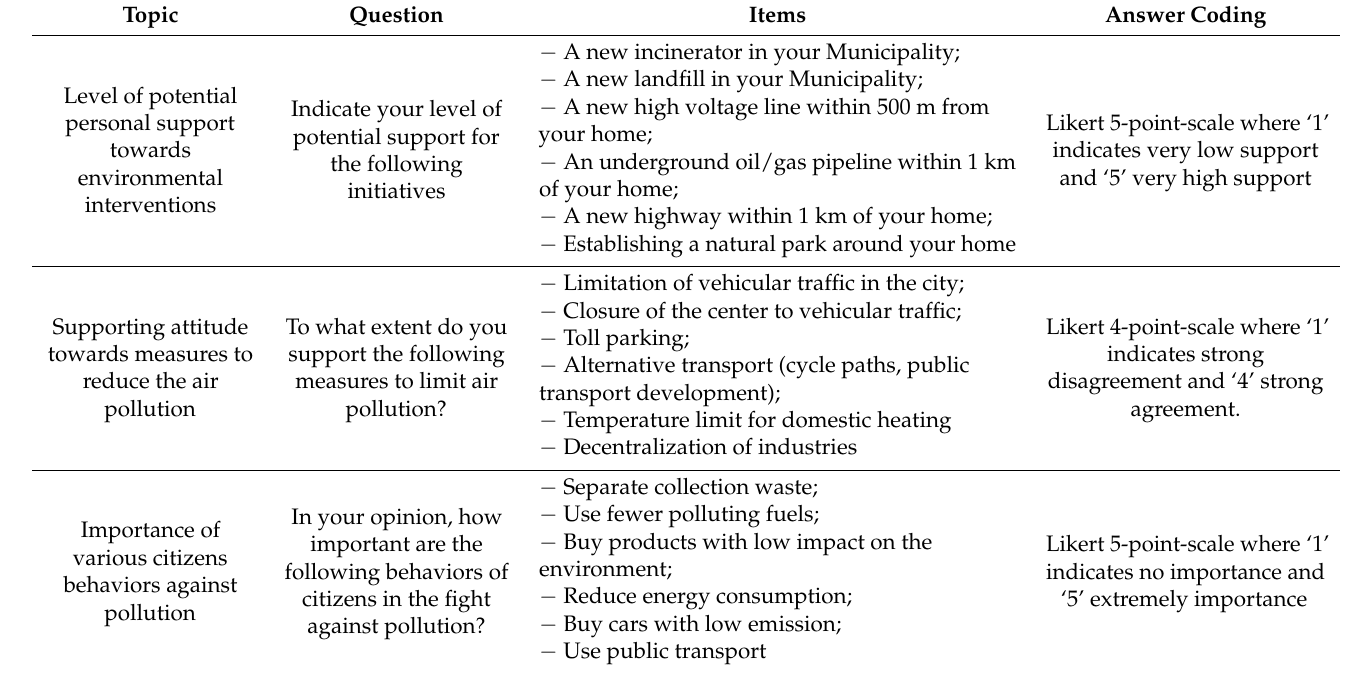
Table 1. Questions, items, and level of measurement used to explore attitudes and behaviors to reduce and control the environmental